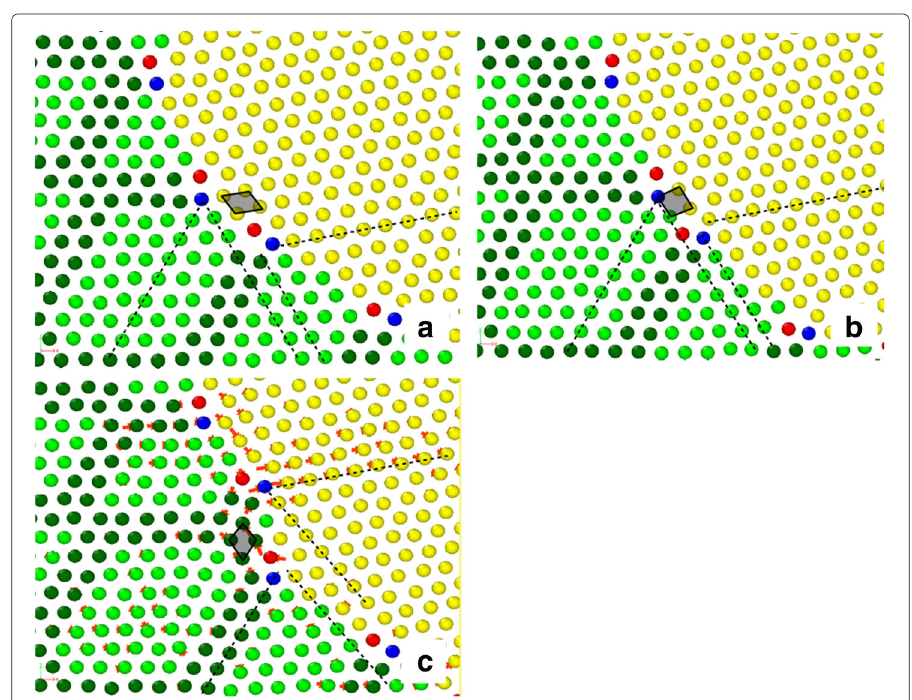
Fig. 7 Effective climb (see text): a two dislocations approach each other (center of the figure); b they arrive at a distance comparable to two interatomic spacings, thus inducing a strong distortion in the surrounding lattice; c a local slip of atoms induces a rotation of the original Burgers vector (atomic displacements are represented by arrows). For the color code, see Fig.